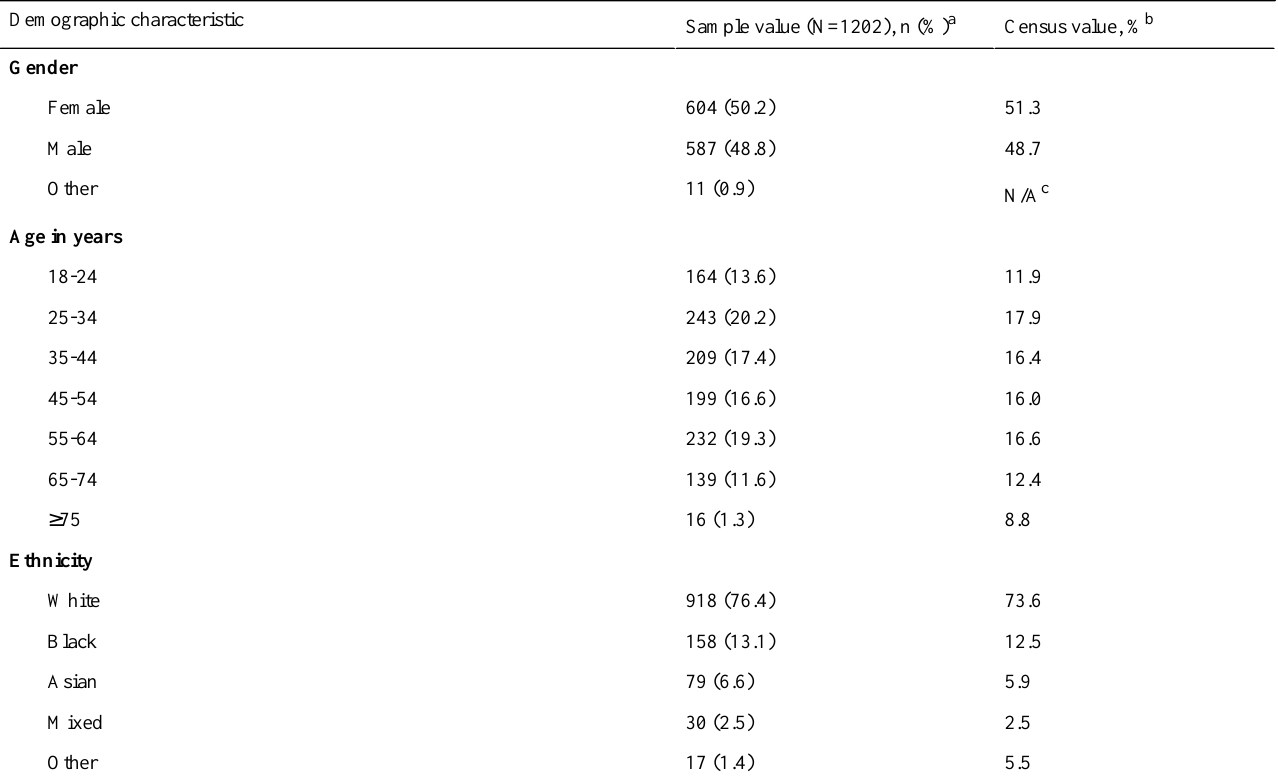
Table 2. Participant